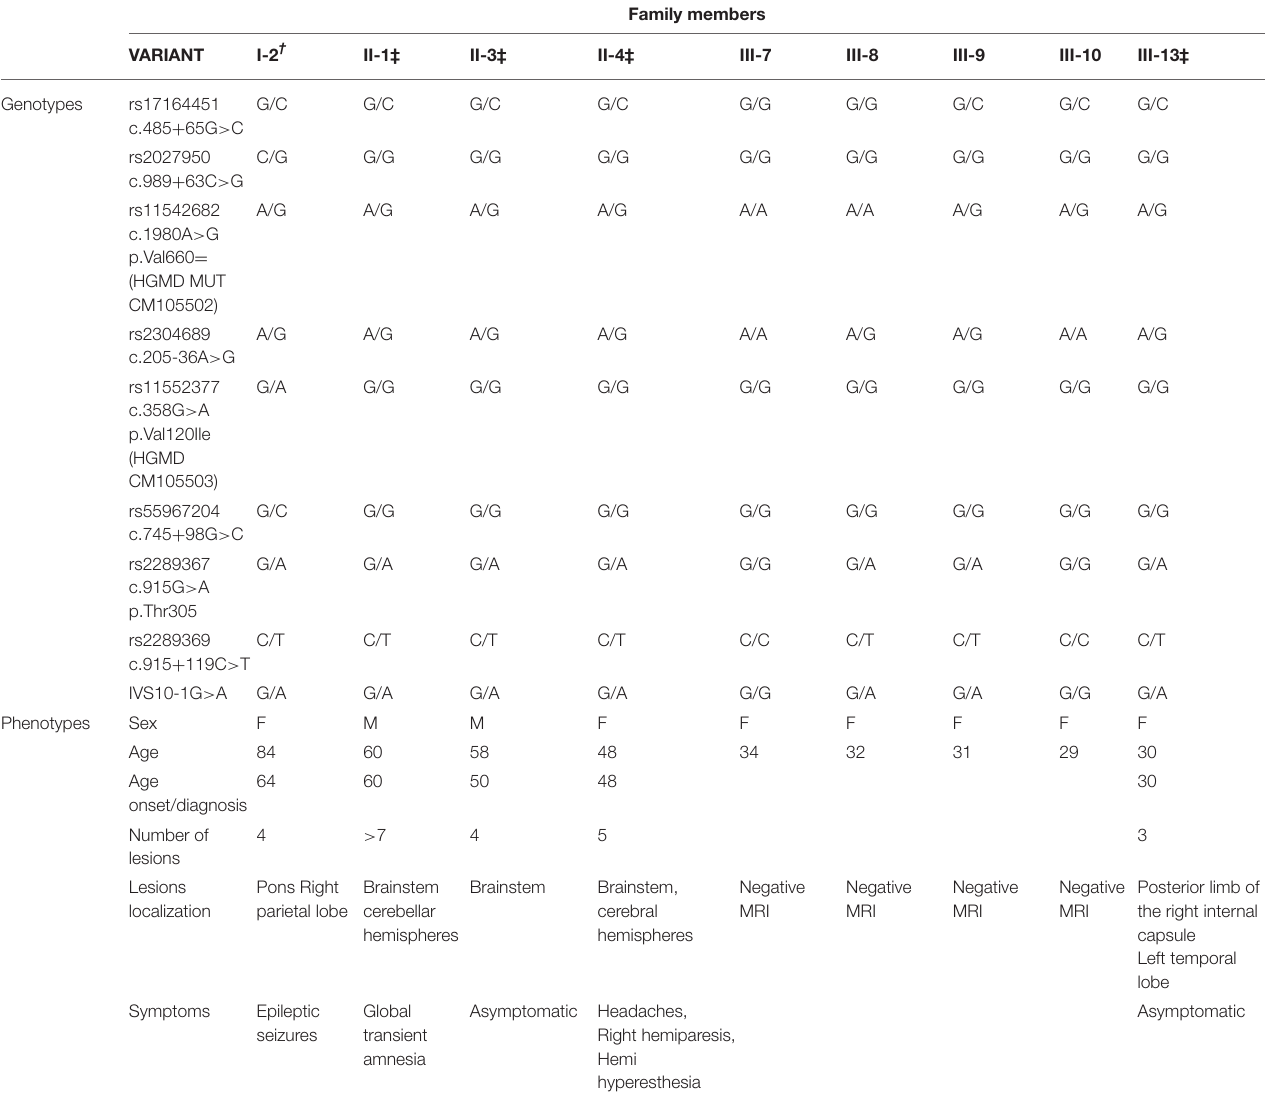
The table is divided in two sections. The upper shows allelic distribution among then family’s members. The lower summarizes their main phenotypical features. † Indicates the proband. ‡ Indicates the affected within the family. Heterogeneity in lesions localization and in symptomatology are reported although equivalence of the